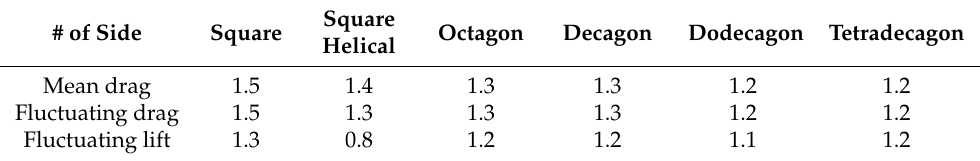
Table 3. Average value of ratio to circular wind turbine for all